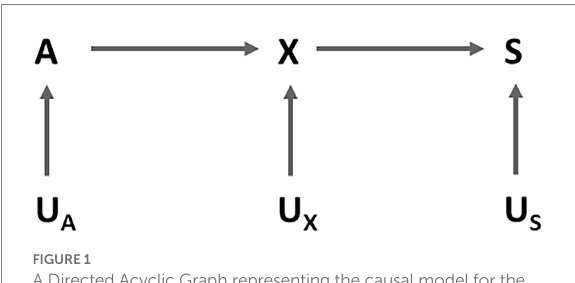
FIGURE 1 A Directed Acyclic Graph representing the causal model for the case study. A is the protected attribute (adhering to a strike), X is the variable indicating whether the rider showed up to work as scheduled or not, and S represents the score used for ranking the riders. Nodes denoted by U represent unmeasured background